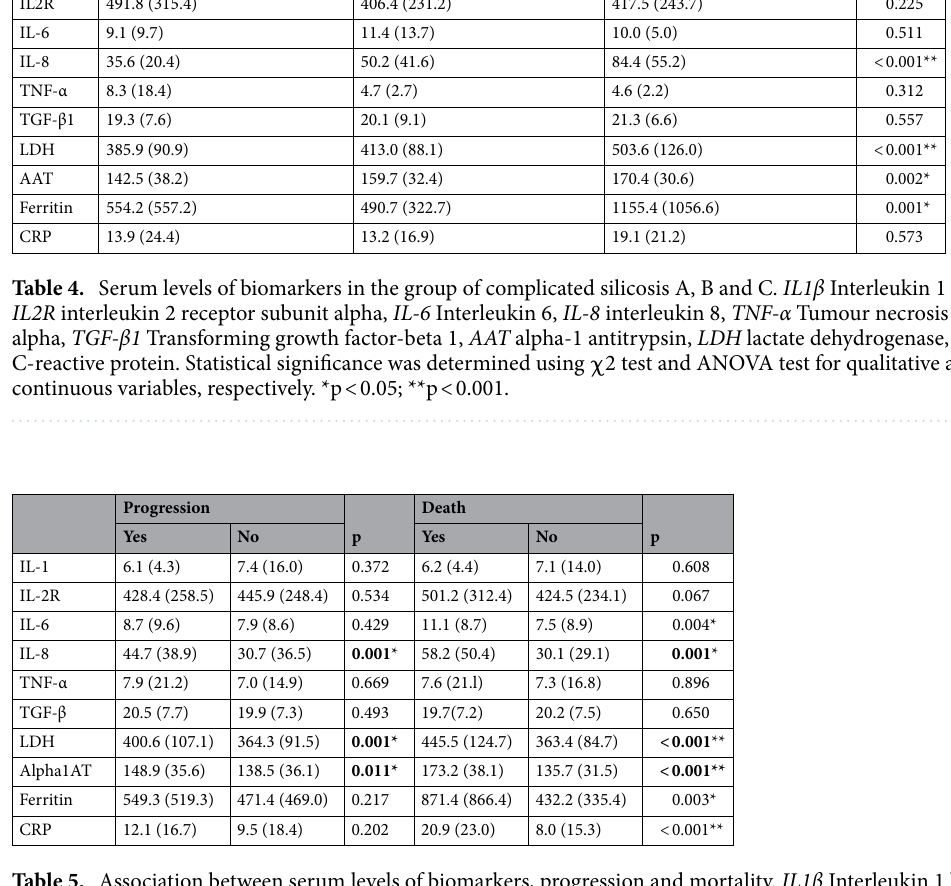
Table 5. Association between serum levels of biomarkers, progression and mortality. IL1β Interleukin 1 beta, IL2R interleukin 2 receptor subunit alpha, IL-6 Interleukin 6, IL-8 interleukin 8, TNF-α Tumour necrosis factor alpha, TGF-β1 Transforming growth factor-beta 1, AAT alpha-1 antitrypsin, LDH lactate dehydrogenase, CRP C-reactive protein. Statistical significance was determined using χ 2 test and T Student test for qualitative and continuous variables, respectively. *p < 0.05; **p < 0.001.